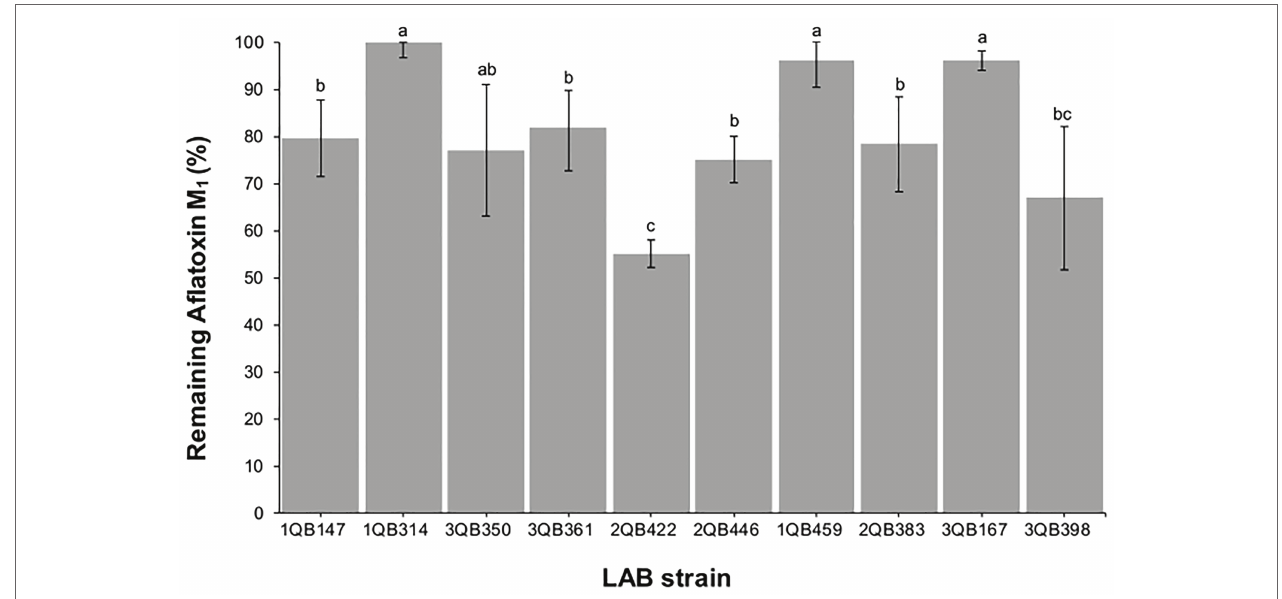
FIGURE 5 | Remaining aflatoxin M 1 in skimmed milk samples spiked at 0.5 μ g ml −1 , after 15 min contact time with heat-inactivated cells of individually tested LAB including: four strains of Lactiplantibacillus plantarum (former Lactobacillus plantarum , comprising strains 1QB147, 1QB314, 3QB350, and QB361), two strains of